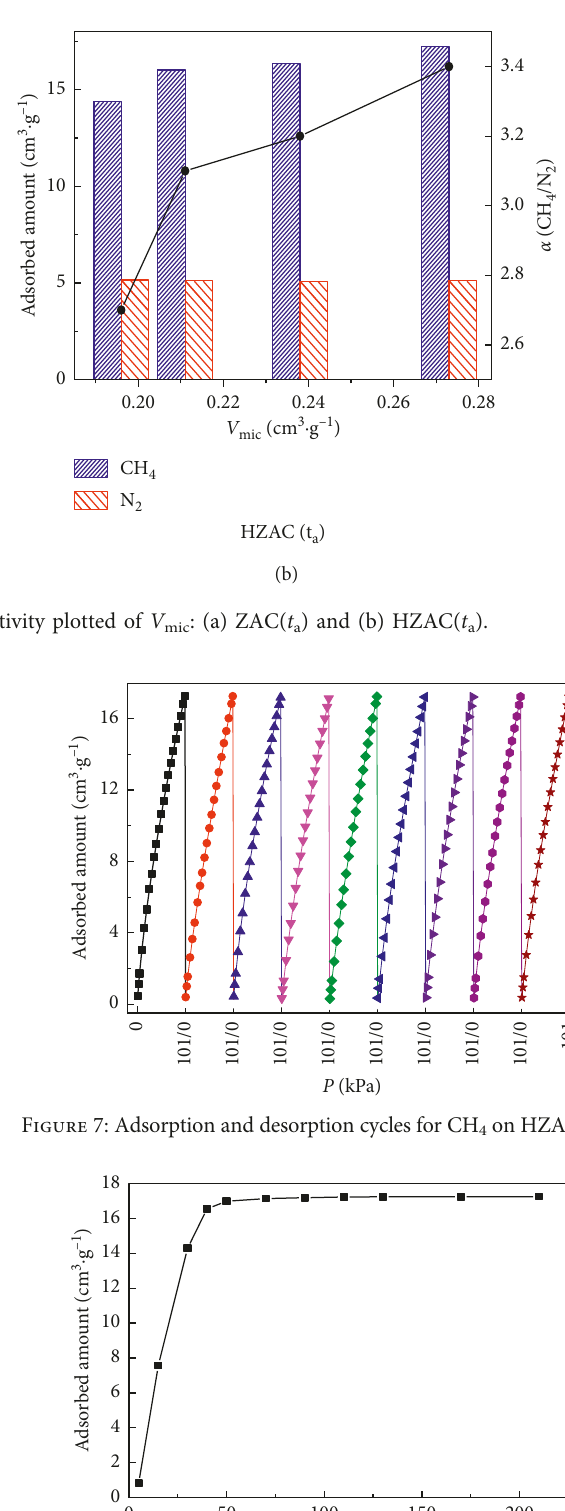
Figure 8: Uptake kinetics for HZAC(24) at